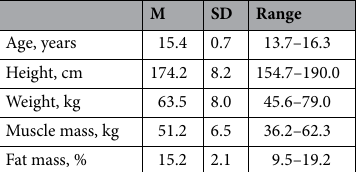
Table 1. Characteristics of the 31 players: means (M), standard deviations (SD) and ranges.